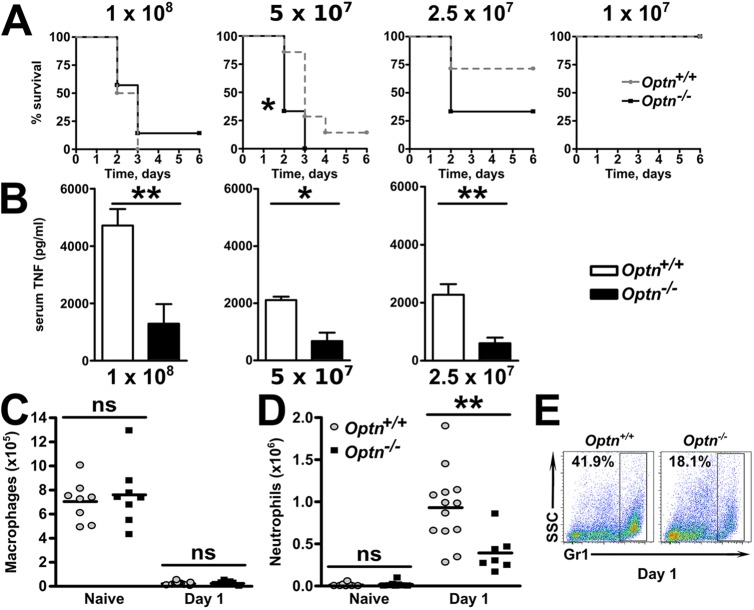
OPTN is protective against in vivo bacterial infection. (A) Optn+/+ and Optn−/− mice were injected with different quantities of live E. coli into their peritoneum (n=4-12 mice/genotype over 3 experiments). (B) Mice were tail bled at day 2 to measure serum TNF levels. (C,D) Peritoneal washouts were performed on naïve Optn+/+ and Optn−/− mice and at day 1 after E. coli inoculation into the peritoneum for flow cytometry of (C) CD11b+ F4/80+ macrophages and (D) Gr1+ neutrophils (n=7-13 mice/genotype over 2 experiments). (E) Representative flow cytometry of Gr1+ neutrophils in Optn+/+ and Optn−/− mice at day 1. Results shown are mean±s.e.m. (*P<0.05 and **P<0.01; two-tailed, unpaired t-test).